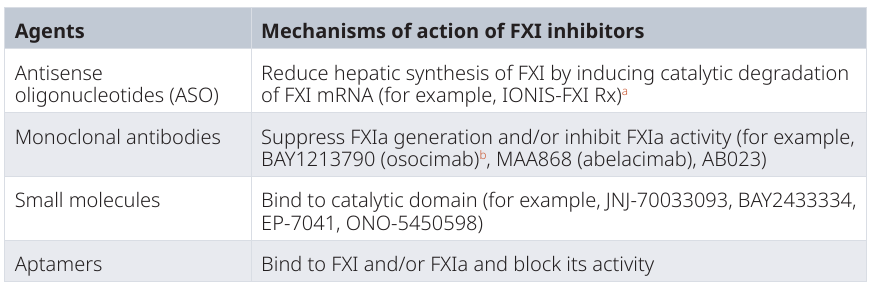
Table 2. Strategies to inhibit factor